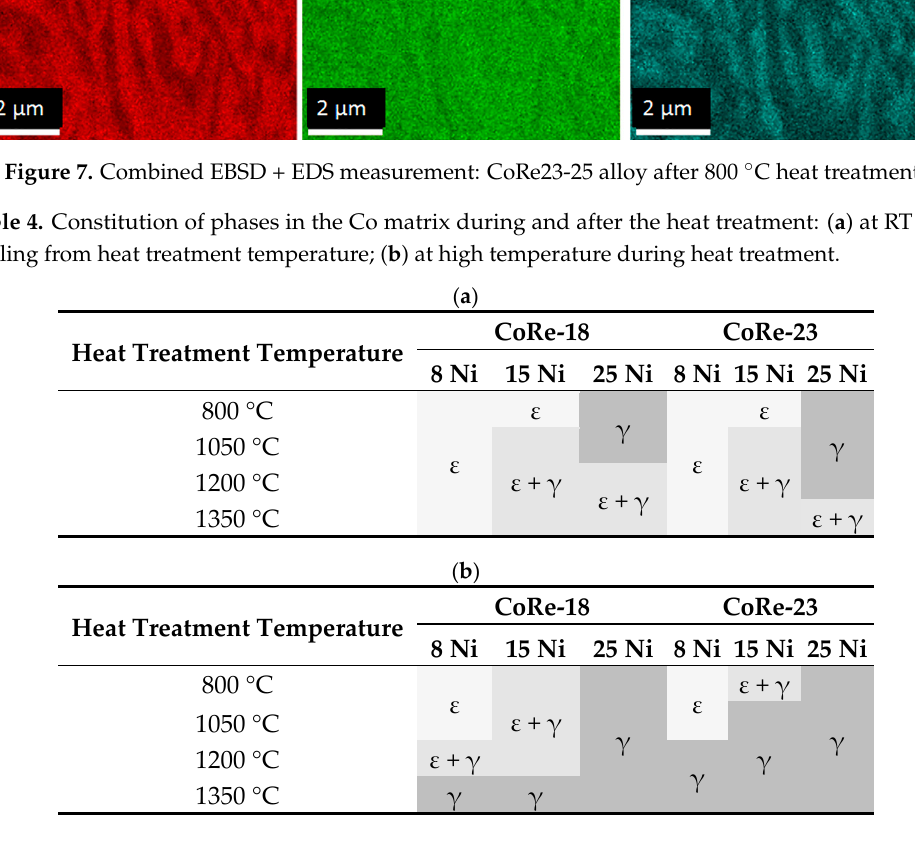
Figure 7. Combined EBSD + EDS measurement: CoRe23-25 alloy after 800 °C heat